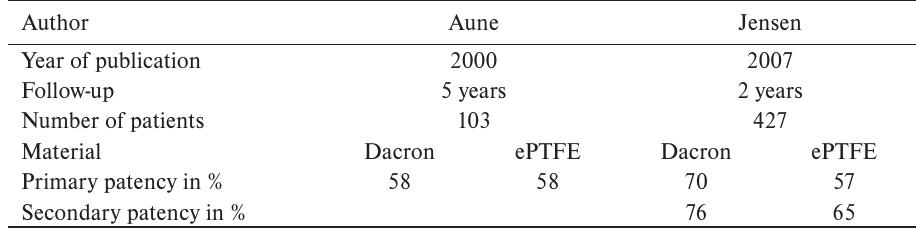
Table 2. Results of FP bypass – comparison of results based on type of prosthesis used.